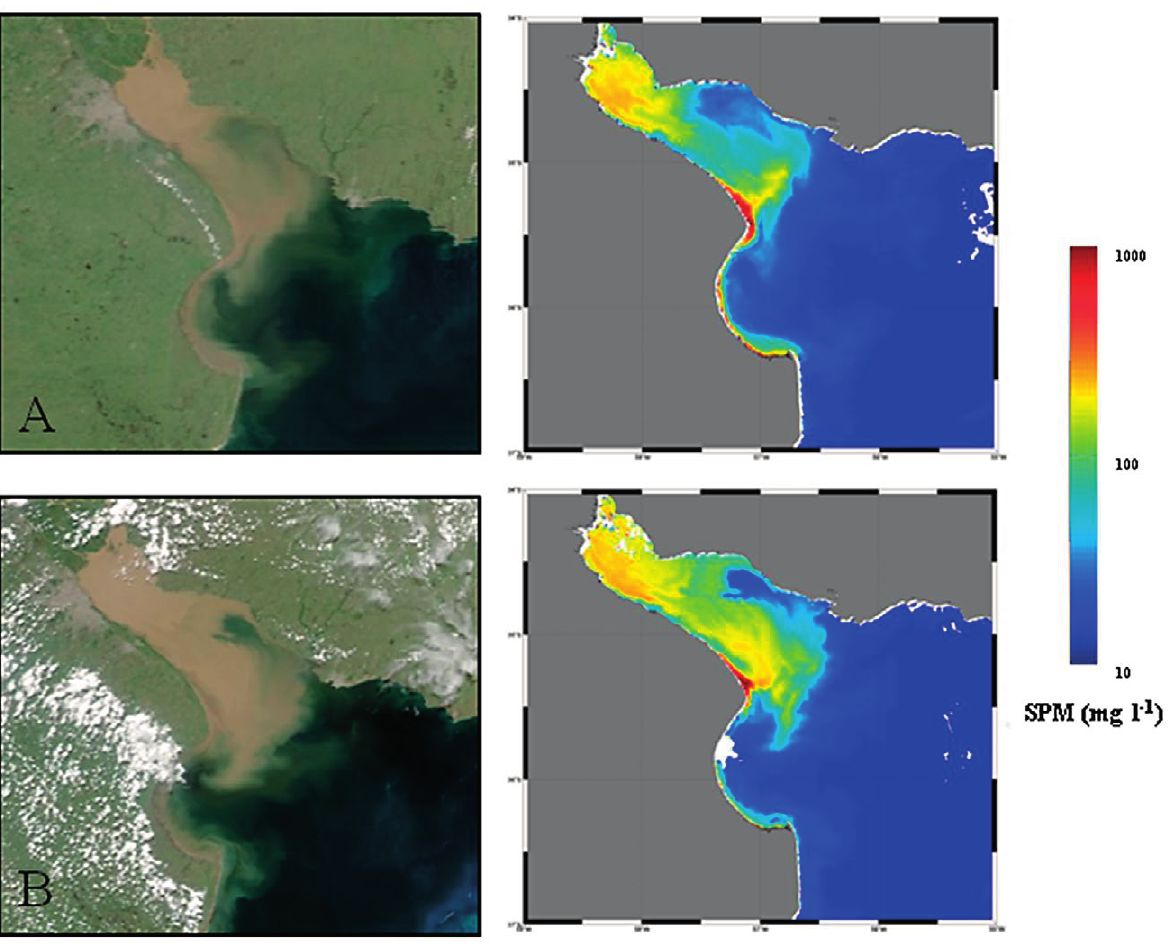
Fig. 7. – MODIS-Aqua Quasi-True-Colour (left panel) and SPM concentration map (right panel) for the Río de la Plata region. Days: January 28 (A) and February 15 (B),